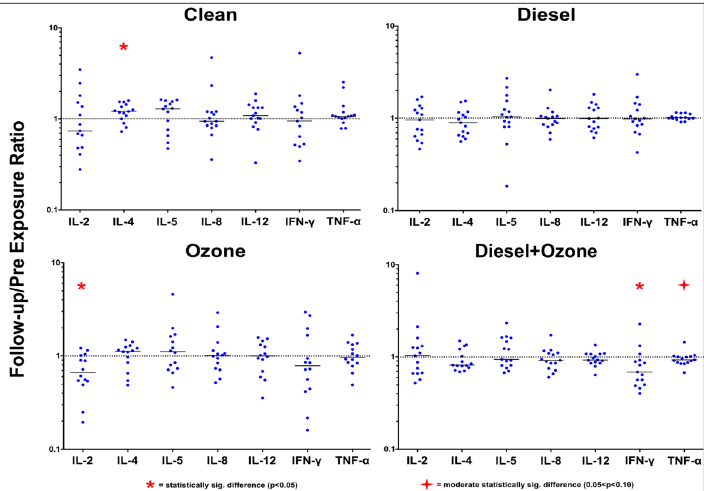
Fig 4. Follow-up/Pre exposure cytokine concentration ratios for the four treatments. Each blue “ dot ” represents an individual Follow-up/Pre cytokine concentration ratio for that respective treatment. A solid line in each of the cytokine scatterplots displays the median follow-up/pre ratio. The dotted line that is anchored at “ 1 ” on each y-axis indicates the ratio where the Pre-exposure concentration is equal to the Follow-up concentration. A statistically significant result above “ 1 ” indicates that there has been an increase in the concentration for that respective cytokine 22-hours after the end of the 2-hour exposure period. A statistically significant result below “ 1 ” indicates that there has been a decrease in the concentration for that respective cytokine 22-hours after the end of the 2-hour exposure